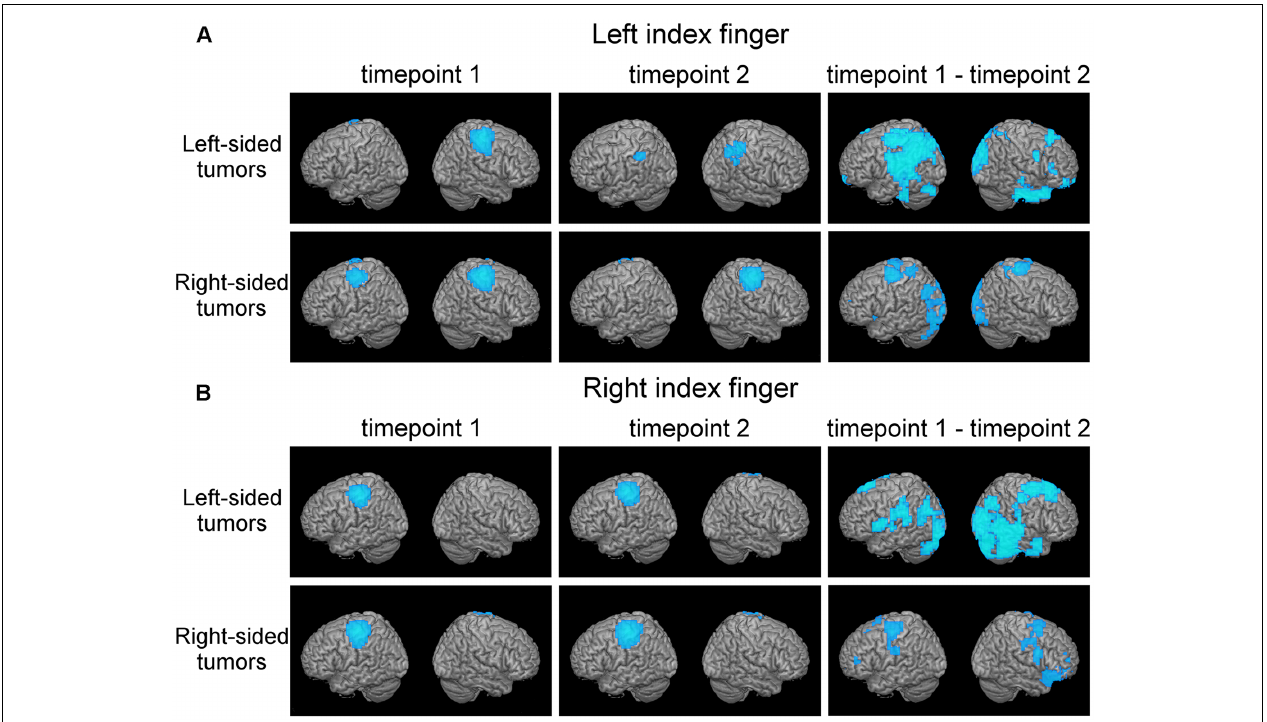
FIGURE 1 | Plasticity in motor cortical activation patterns across observational periods reveals shifts in the contralateral motor cortex (MC) and disengagement of ipsilateral motor cortical regions. This figure shows average motor activation (thresholded at full-width-at-half-maximum) at first (left columns) and second (middle column) timepoint, respectively, in patients with frontal-insular-temporal tumors. Also, statistically significant changes in activation patterns (first minus second time point; blue areas indicate decreased activation at second timepoint) are shown (right column, p < 0.05 with a cluster threshold of 20 voxels). Rows indicate different tumor locations. Activation during both the left index finger (A) and right index finger (B) motor task is shown.